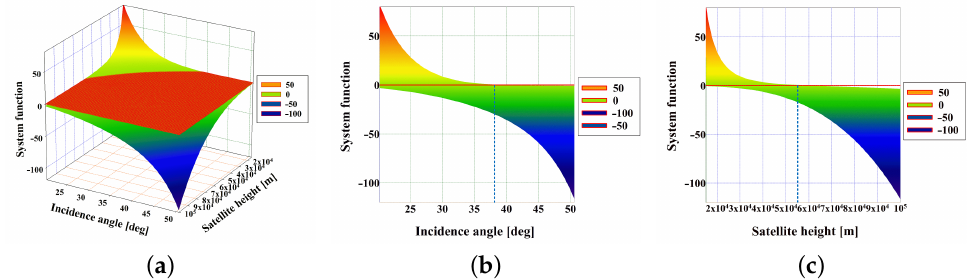
Figure 5. ( a ) When the average transmitting power and the number of multi-looks are P av = 6000 W and L look = 10, the system function changes with the incidence angle φ and satellite height H sat . ( b , c ) are the simulation results of the system function varying with φ and H sat ,